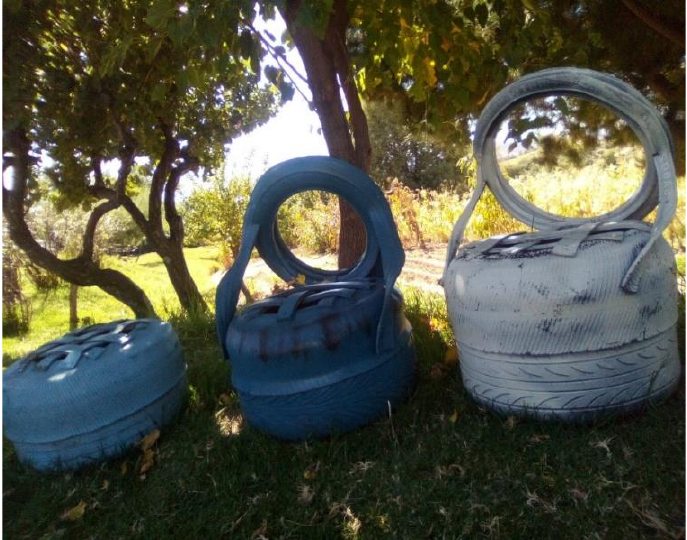
Figure 3. The illustration of old tyres converted into chairs in Matsieng Constituency. Picture taken by Teboho Maretlane in May 2021.